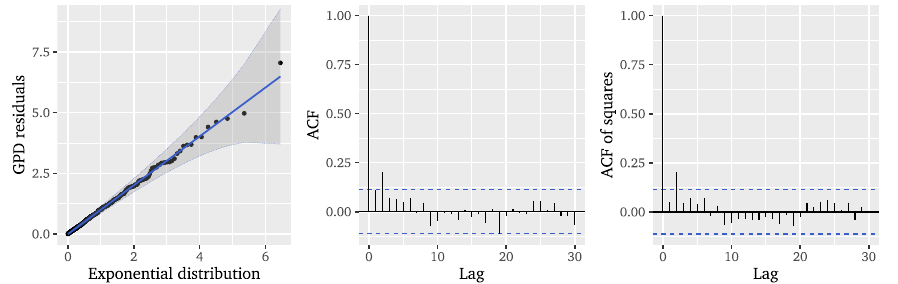
Figure 12. Unit exponential QQ plot and auto-correlation functions for the GPD residuals of the